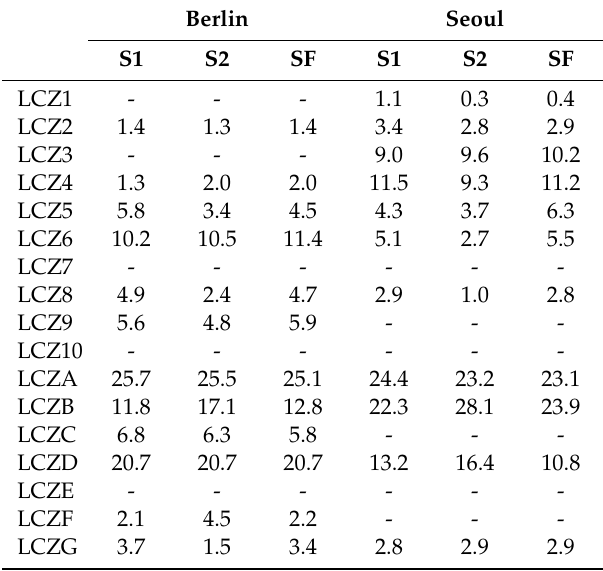
Table 5. The area ratio of each LCZ class to the total area on the maps of S1, S2, and SF for both Berlin and Seoul. Berlin